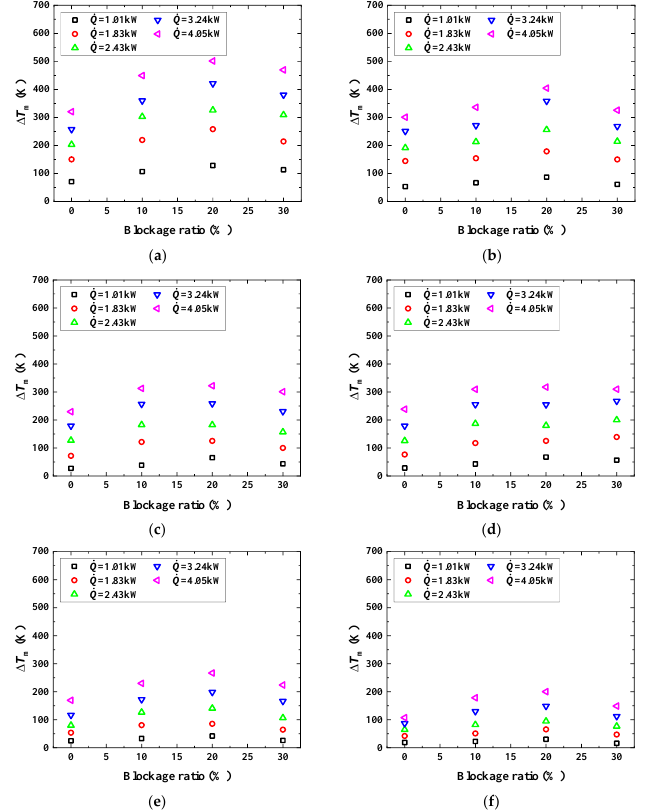
Figure 9. The maximum temperature rise varies with blockage ratio: ( a ) Scheme 1; ( b ) Scheme 2; ( c ) Scheme 3; ( d ) Scheme 4; ( e ) Scheme 5; ( f ) Scheme 6. The experimental data were processed by the maximum temperature rise prediction Equation (6) proposed by Li [16]. The sum of the velocities of ramps C and D was used as the characteristic velocity. The maximum temperature rise data fit well, as shown in Fig- ure 10. It demonstrated how the velocities of ramp C and ramp D had an impact on the maximum temperature rise. However, the experimental results were lower than the pre- diction of Equation (6).